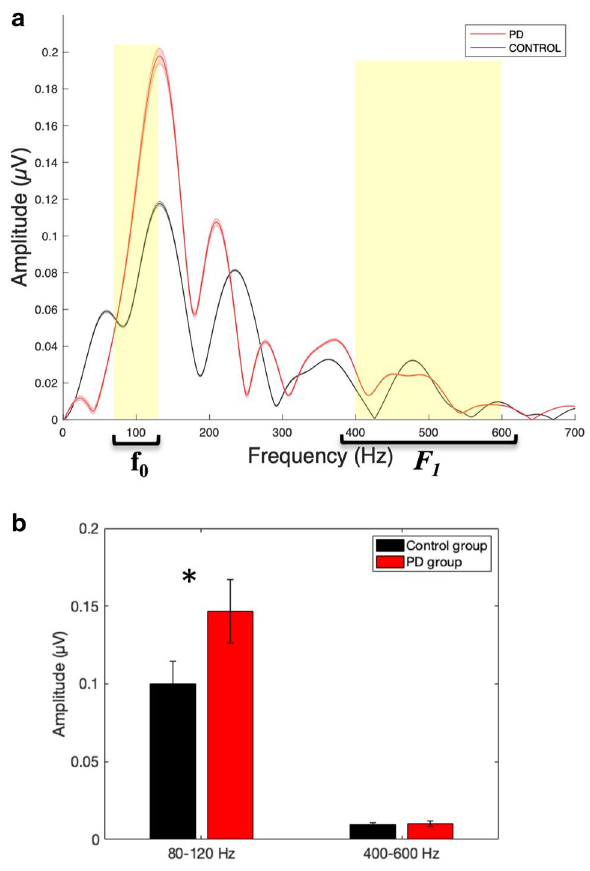
Figure 2. ( a ): Fast Fourier transforms calculated for the vowel part of the average response of individuals with PD (red) and age- and gender-matched control (black) group. ( b ) Bar graphs demonstrating between-group differences in response amplitude corresponding to f o (80–120 Hz) and F 1 (400–600 Hz) representation of the speech stimuli. The error and shaded error bars represent the standard error. Note : * p <